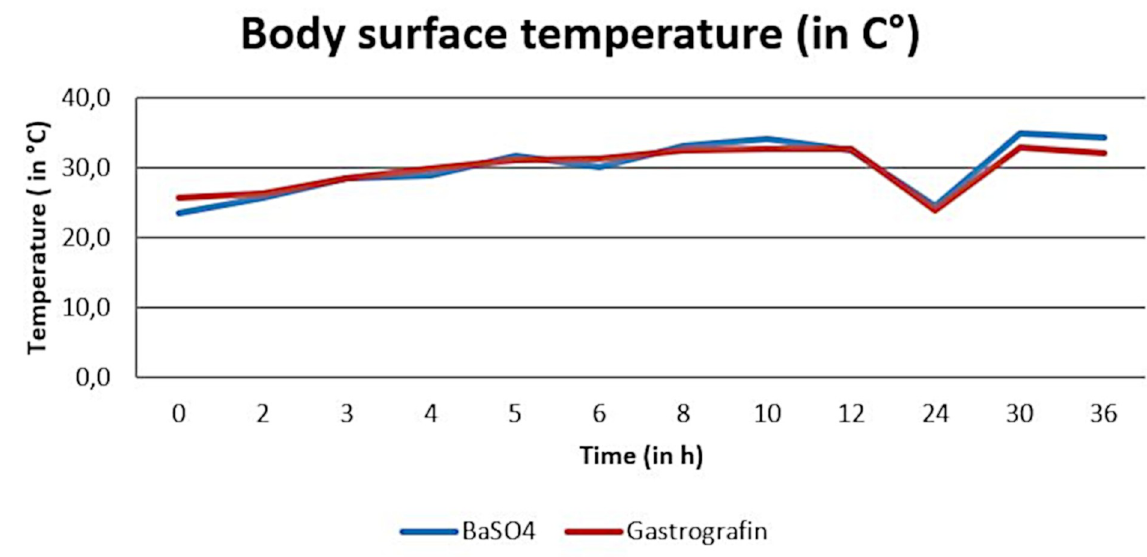
Fig 3. Arithmetic mean of body surface temperature (in˚C) during the barium sulfate and Sodium/Meglumine–Amidotrizoate (SMAT, Gastrografin) contrast passage.